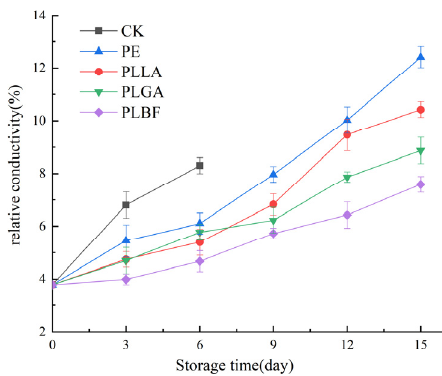
Figure 9. Changes of MDA of Agaricus bisporus in each packing group during storage.